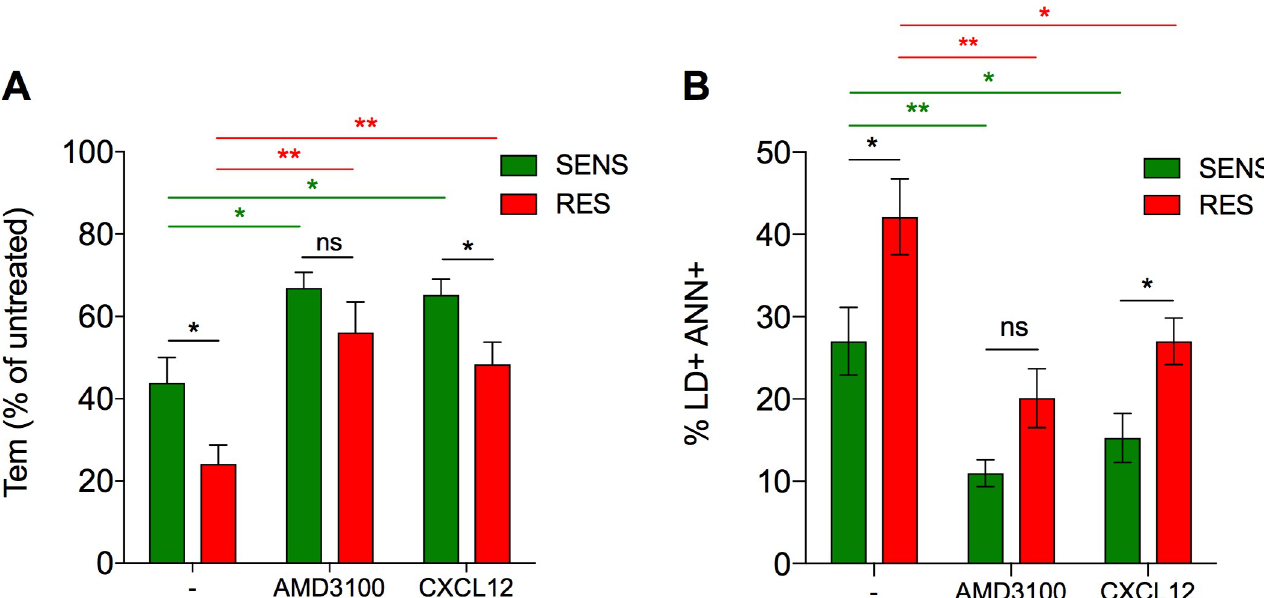
Fig 6. Death of bystander CD4TL is increased in the presence of RES viruses. A Percent depletion of bystander Tem cells among the fraction of SSC-high CD4TL in the presence of R5X4JT cells infected with SENS or RES viruses, compared to conditions with uninfected cells, w/ or w/o 10 μ M AMD3100 or 300 nM CXCL12. B Percentage of Live/Dead and Annexin V positive cells within the fraction of SSC-high CD4TL after incubation with R5X4JT cells, in the presence or absence of AMD3100 or CXCL12. Results are means ± SEM of two independent experiments.